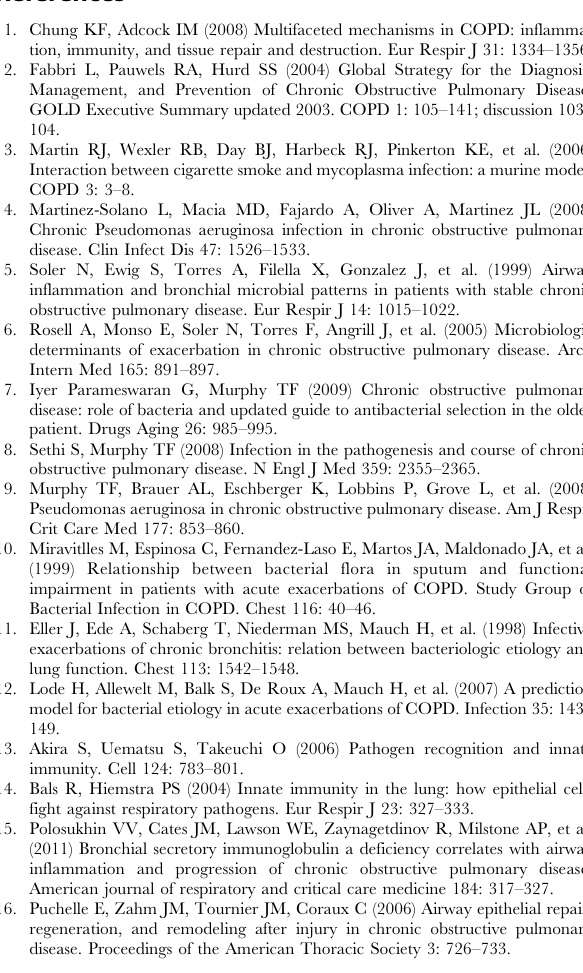
Figure S1 Successful knock down and overexpression of FABP5 in primary NHBE cells. A. FABP5 knock down